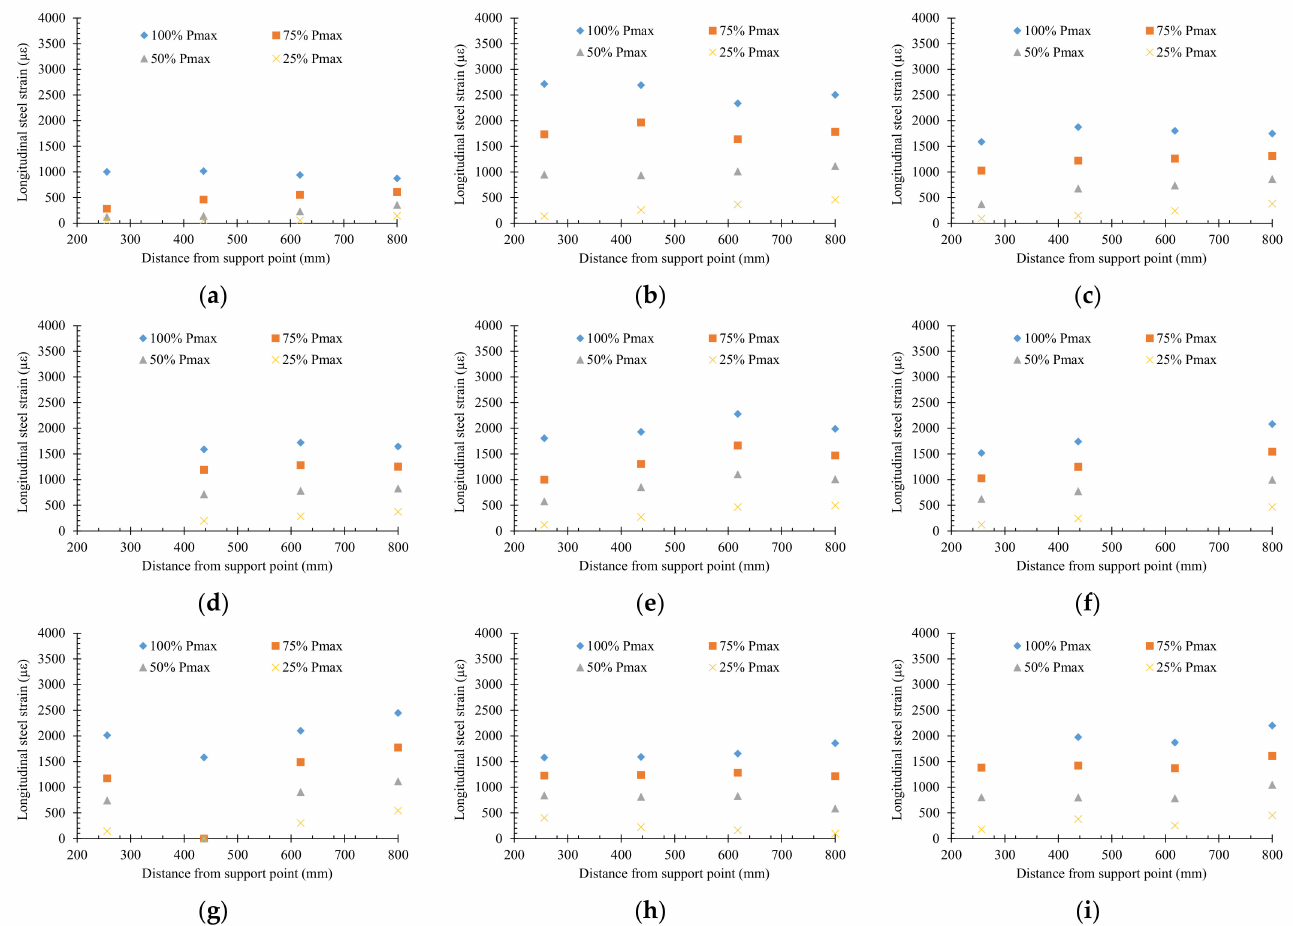
Figure 13. Steel strain profile: ( a ) Control-NS; ( b ) Control-ST; ( c ) NS-C2-90; ( d ) NS-C2-0/90; ( e ) ST-C1-90; ( f ) ST-C2-90; ( g ) ST-C2-0/90; ( h ) NS-G1-90; ( i )